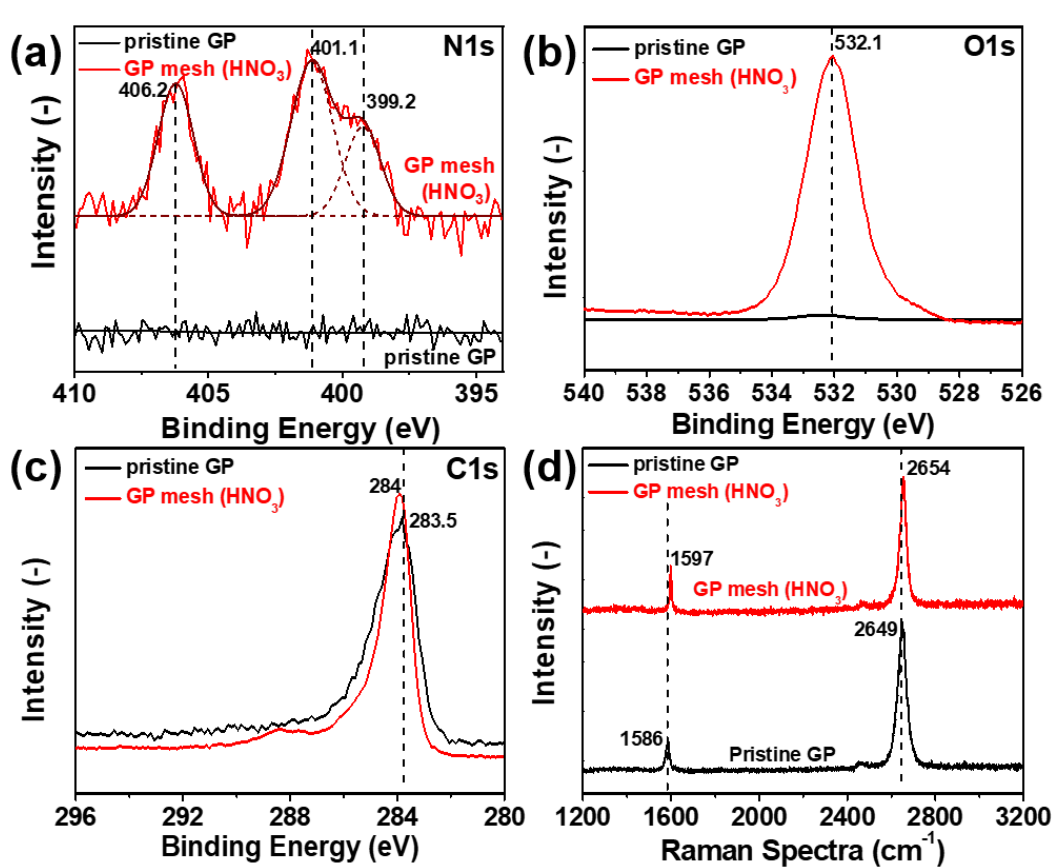
Figure 2. Structural analyses of irregularly patterned GP mesh and pristine GP by chemical etchants (treatment: 5 M HNO 3 for 10 min) X-ray Photoelectron Spectroscopy (XPS) of pristine and patterned GP meshes by etch-patterning ( a ) N1s, ( b ) O1s, ( c ) C1s; Raman spectroscopy of pristine and GP